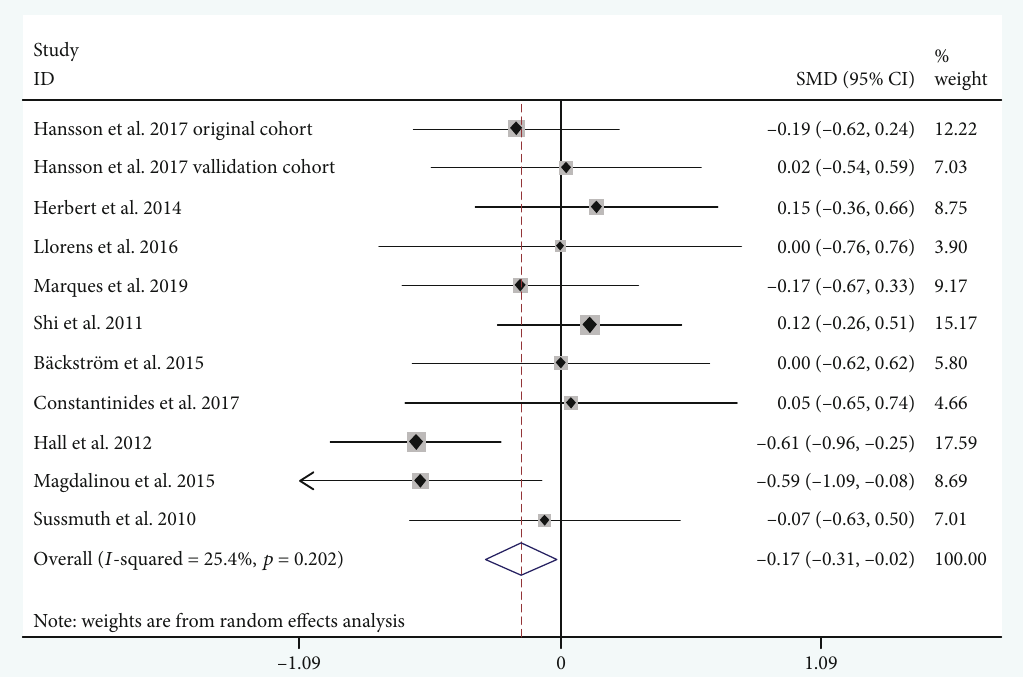
Figure 4: Cerebrospinal fl uid (CSF) levels of phosphorylated tau (p-tau) in multiple system atrophy (MSA) cohorts were lower than those in Parkinson ’ s disease (PD) cohorts after sensitivity analysis.